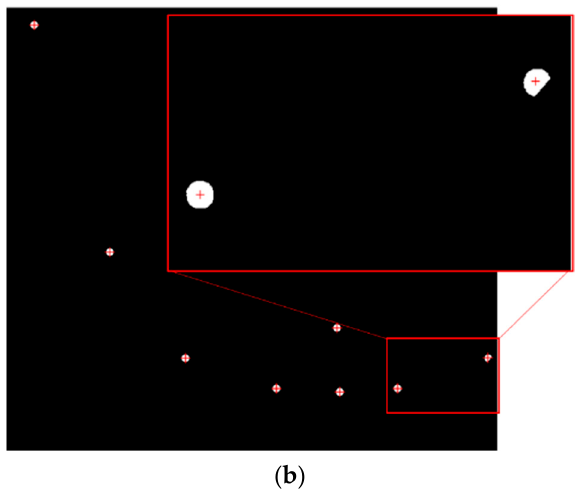
Figure 14. ( a ) Temporal evolution of the centroiding errors over a single simulation for test case S3; ( b ) partial loss of marker #6 at 320 s.